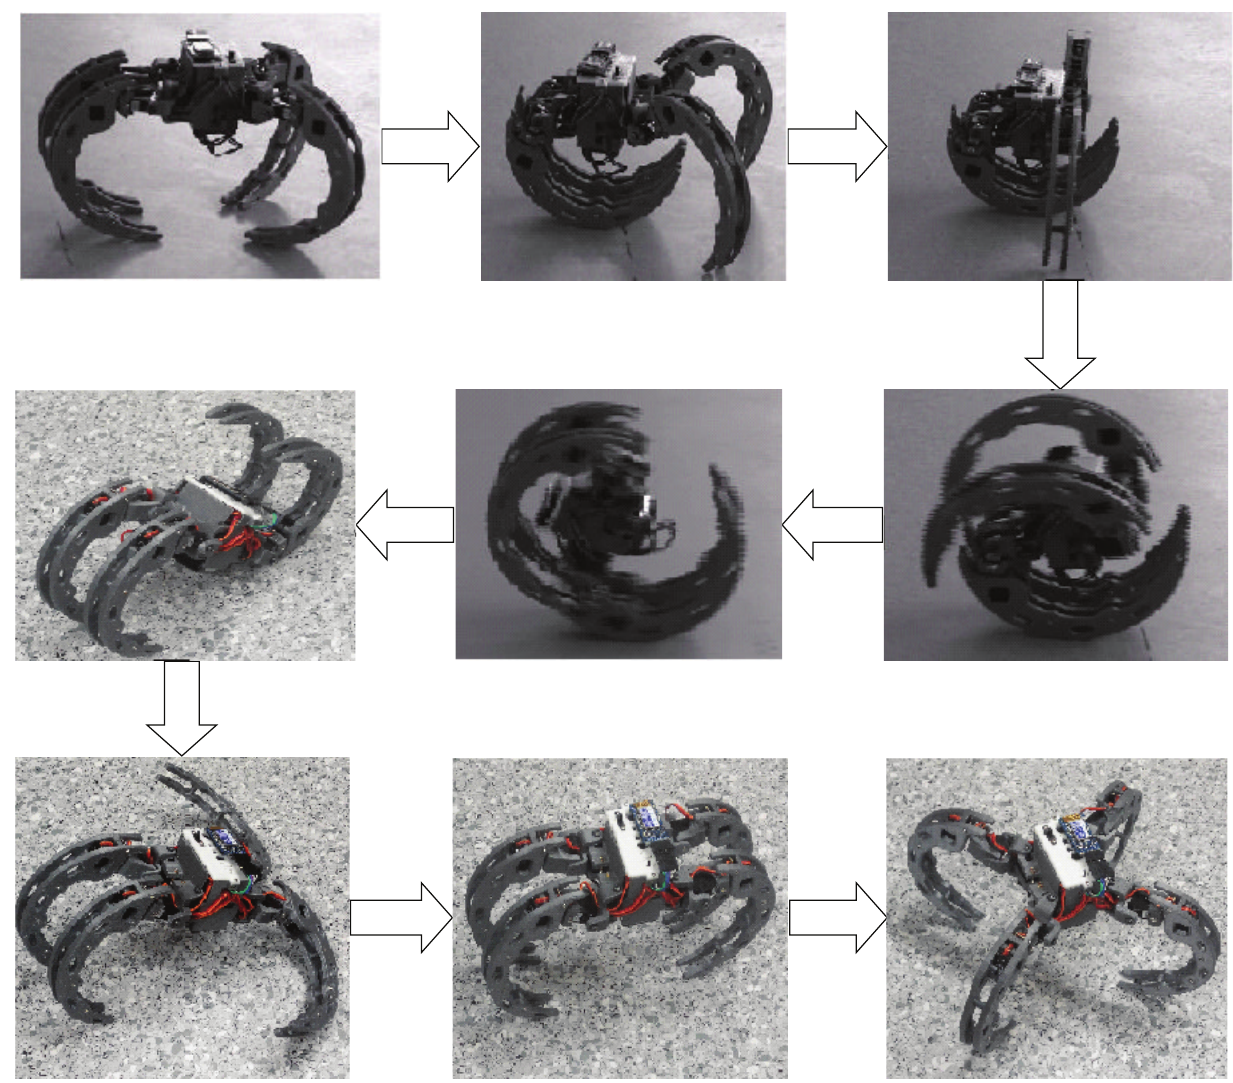
Figure2:Transformationbetweenwalkingandrolling.Thequadrupedrobothasthewalkingformandrollingoneandcantransformbetween walking and rolling by reconfiguring their legs.